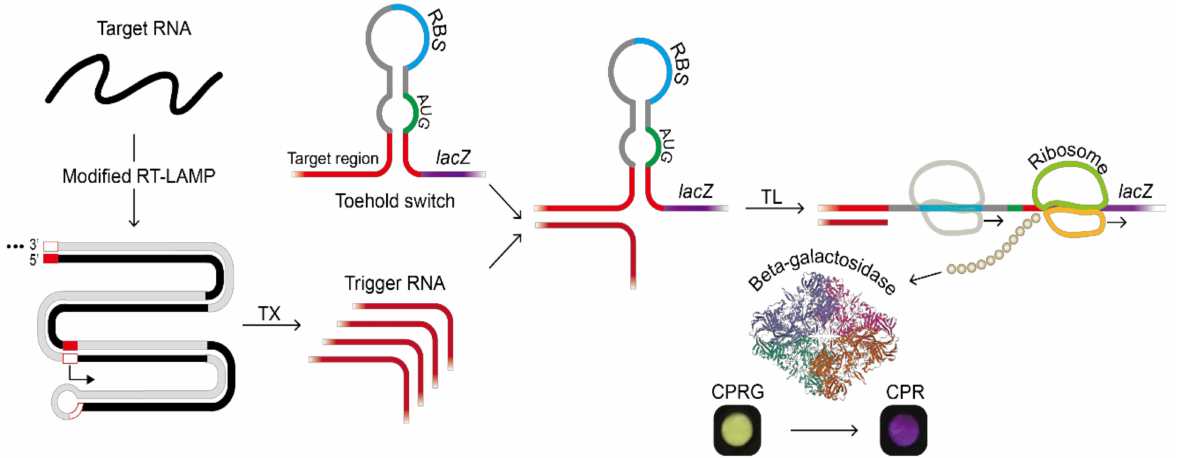
Figure 1. Target RNA detection scheme using the modified reverse transcription loop-mediated amplification (RT-LAMP) developed in this study and subsequent toehold reaction in a paper-based cell-free protein expression system. The reporter protein, beta-galactosidase, catalyzed the conversion of chlorophenol red-D-galactopyranoside (CPRG) to chlorophenol red (CPR). Beta-galactosidase structure was from PDB ID 6DRV, beta-galactosidase [17]. (Abbreviation: RBS, ribosome binding site; TL, in vitro translation; TX, in vitro